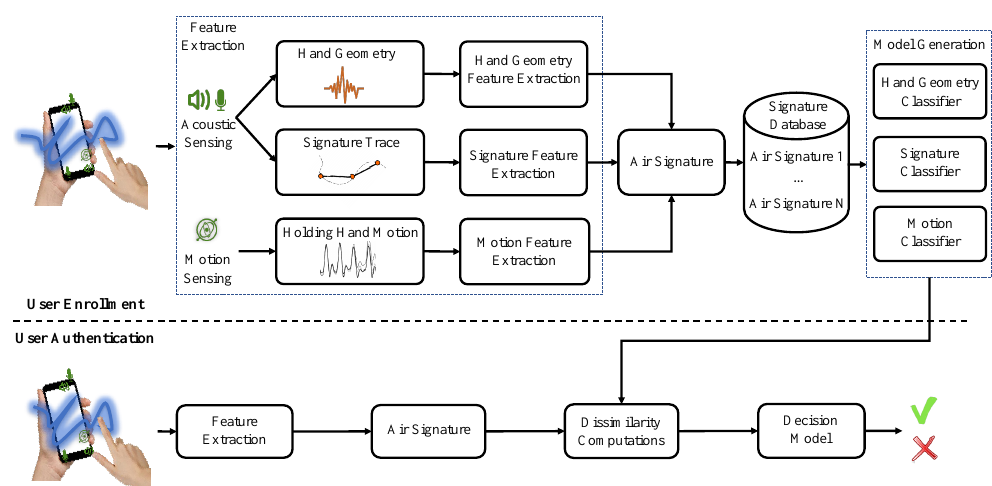
Figure 2. AirSign system architecture—user enrollment and user